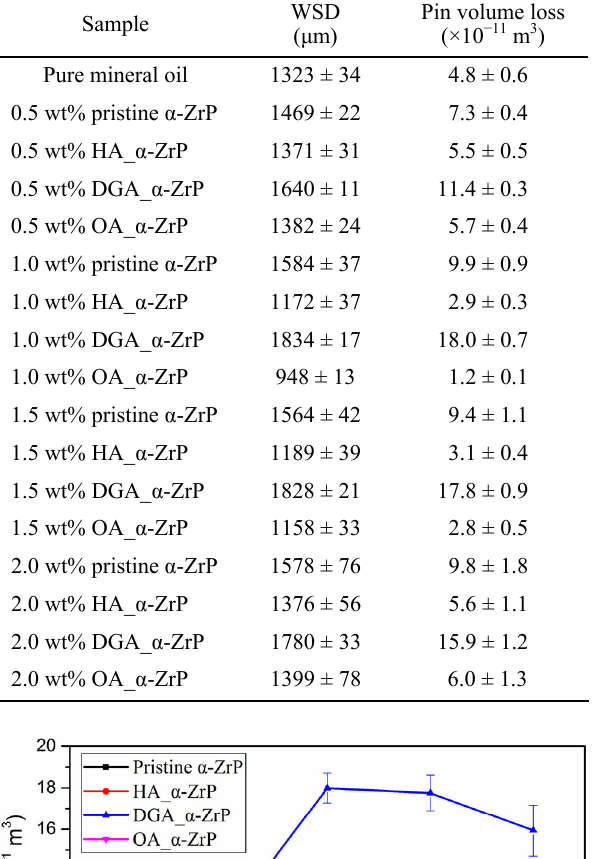
Table 2 WSD and pin volume loss values for pure mineral oil and mineral oil dispersions containing different concentrations of pristine and amine-intercalated  -ZrP nanosheets.